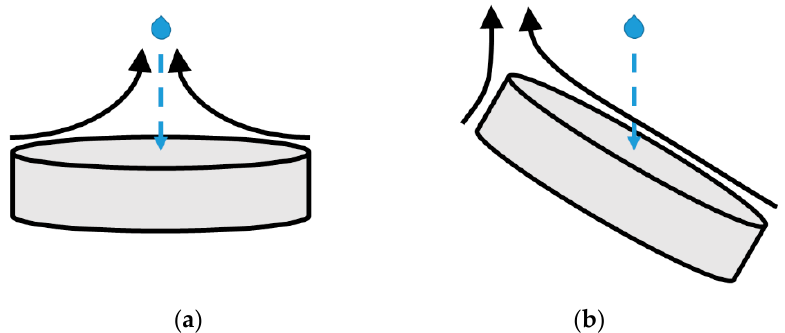
Figure 3. Sketch of the droplet impact point (blue lines) and convective air cooling flow for the upward facing disc surfaces (black lines) in both horizontal ( a ) and inclined surfaces ( b ).